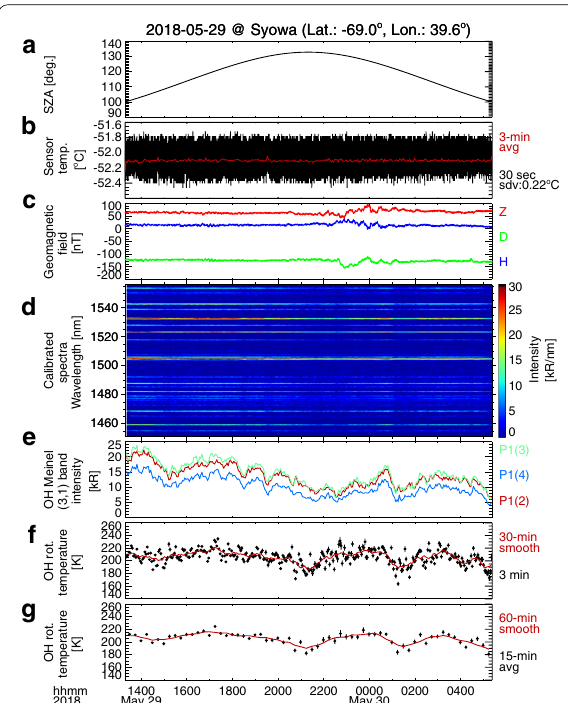
Fig. 4 A summary plot for NIRAS measurements of OH Meinel (3,1) band and estimated OH rotational temperature on May 29, 2018. a SZA as a function of time b Sensor temperature variations in every 30 s (black) and 3-min average (red) c Geomagnetic field variations in H, D, and Z components observed by a fluxgate magnetometer at Syowa d Dynamic spectrum from 1451 to 1557 nm obtained by the NIRAS. e P 1 (2), P 1 (3), and P 1 (4) line intensities in OH (3,1) band as a function of time. f Estimated OH rotational temperatures in every 3 min (black diamonds) and 30-min smoothed temperatures (red line). Errors of estimated temperatures are mostly less than 4 K. g Same as ( f ) but 15-min averaged temperatures by error-weighted scheme (black diamonds) and 60-min smoothed temperatures (red line)